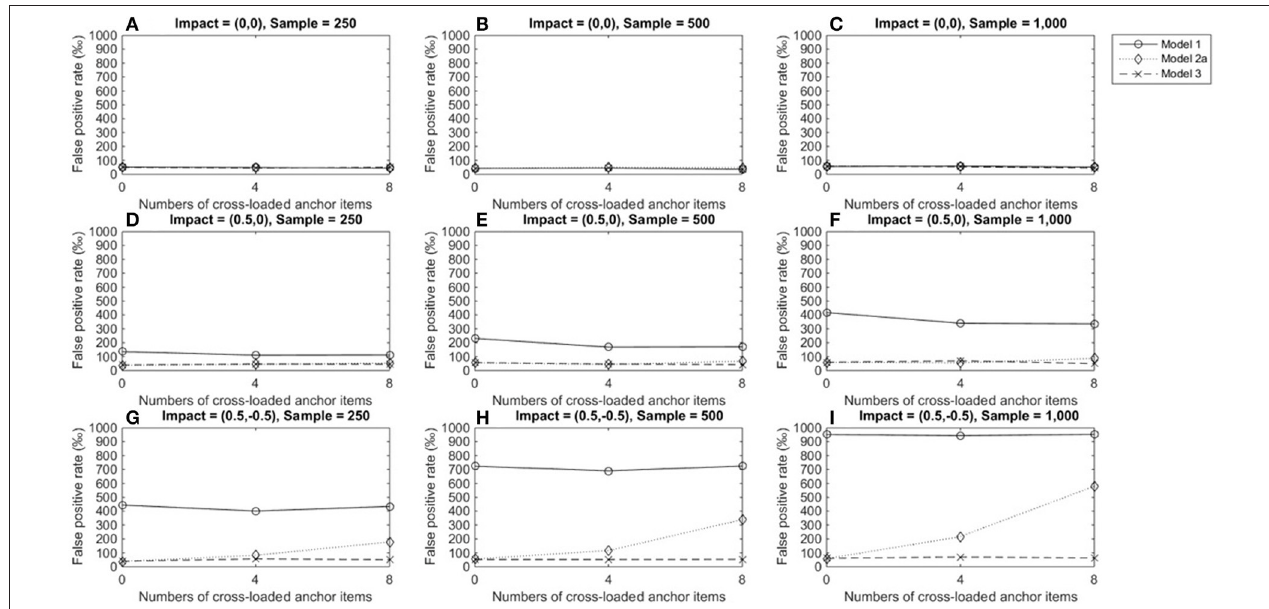
FIGURE 2 | False positive rates when the tested item measured one single domain. For model 1, total scores served as a matching variable; for model 2a, the subset score of domain 1 was used to match participants; model 3 used two subset scores as a matching variable. Model 2b was excluded because the tested item did not measure the second domain. (A) Impact = (0,0), Sample = 250; (B) Impact = (0,0), Sample = 500; (C) Impact = (0,0), Sample = 1,000; (D) Impact = (0.5,0), Sample = 250; (E) Impact = (0.5,0), Sample = 500; (F) Impact = (0.5,0), Sample = 1,000; (G) Impact = (0.5, − 0.5), Sample = 250; (H) Impact = (0.5, − 0.5),